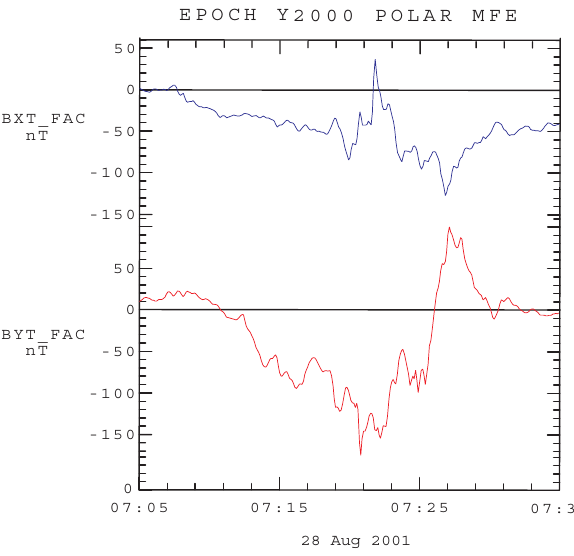
Fig. 4. The magnetometer data obtained by the MFE on board the Polar spacecraft for the same time interval. The figure shows dB x and dB y (perpendicular to ambient magnetic field) in field-aligned coordinates. The characteristic signature of a field-aligned current is observed along with f ∼ 1/30s